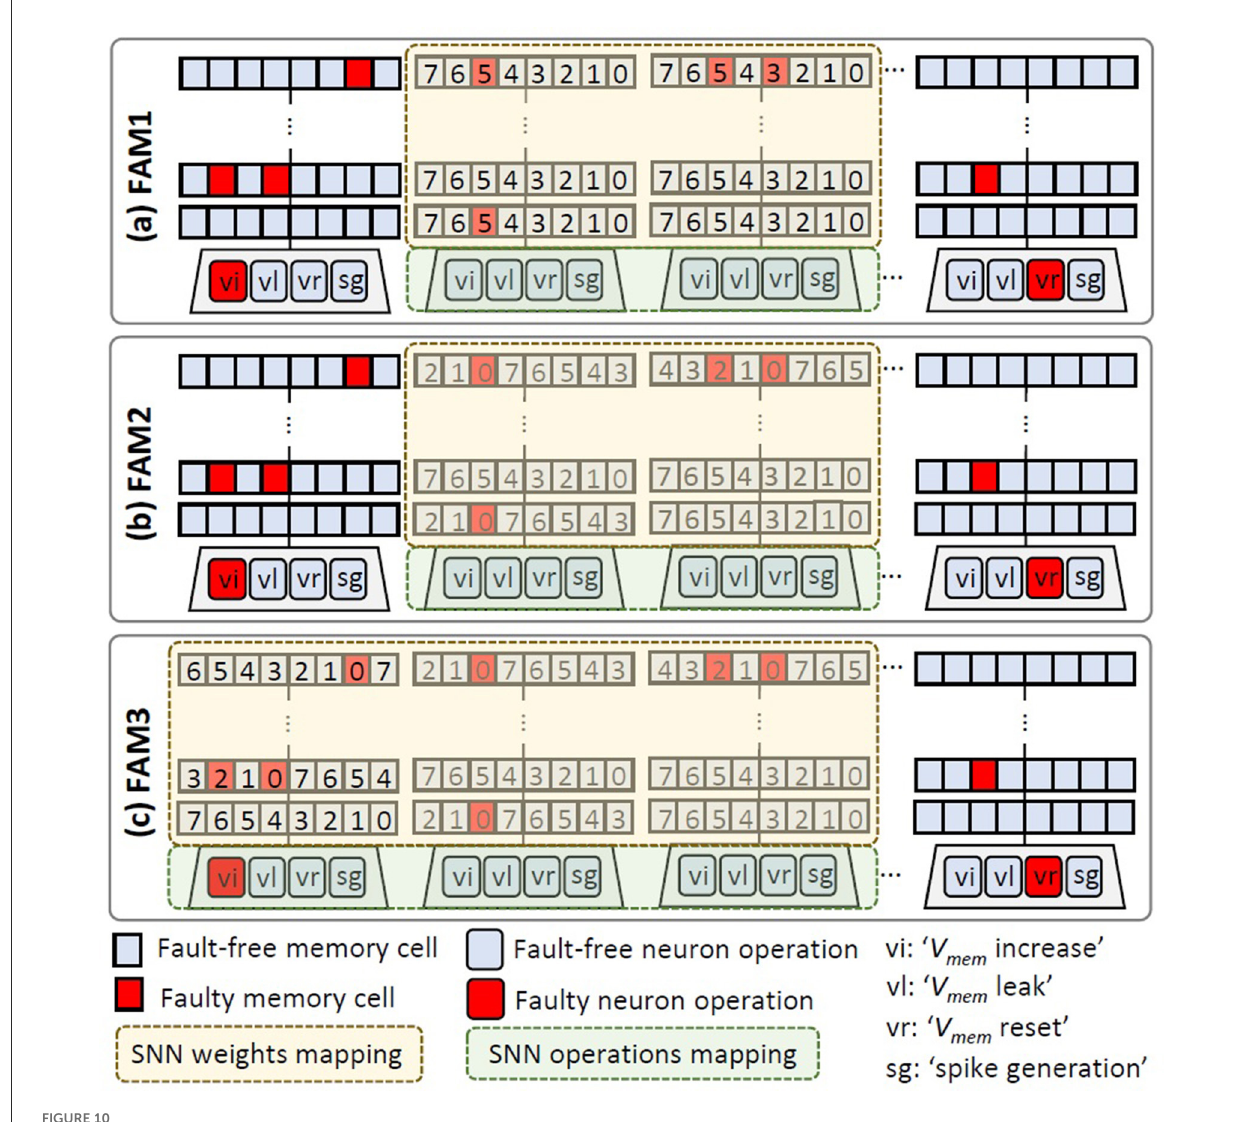
FIGURE10 Our FAM strategies: (a) FAM1, (b) FAM2, and (c) FAM3.